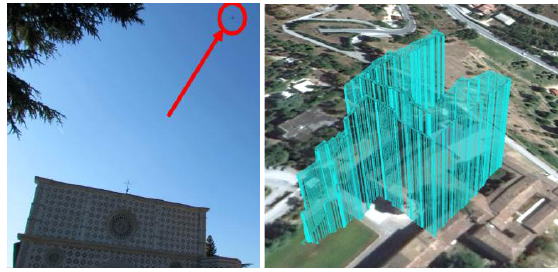
Fig. 3. The UAV fligh over the Basilica di